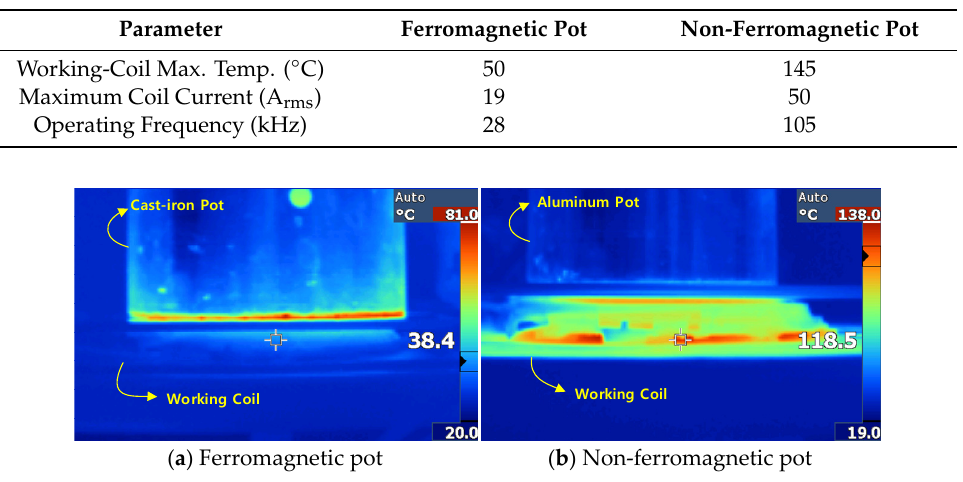
Figure 12. Working-coil temperature according to the pot material during IH.